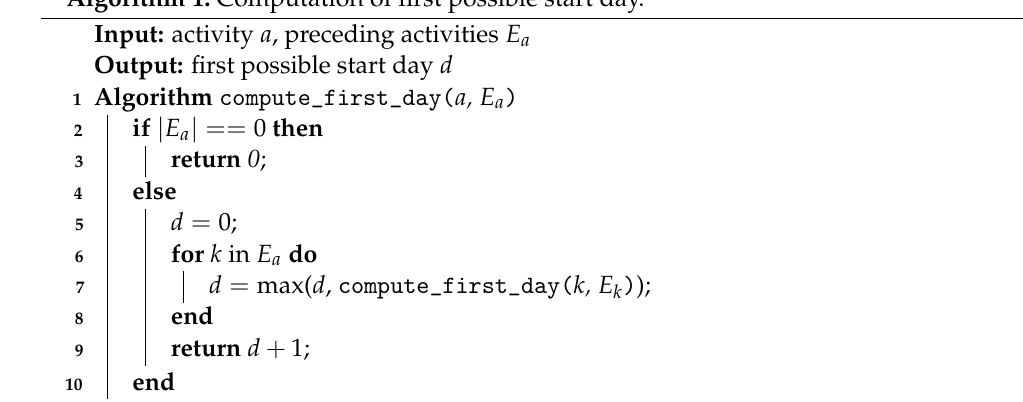
Algorithm 1: Computation of first possible start